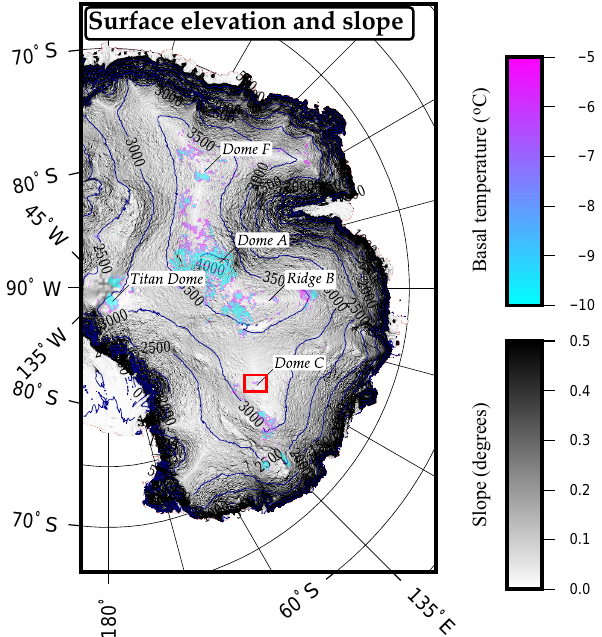
Figure 1. The East Antarctic ice sheet showing the Van Liefferinge and Pattyn (2013) frozen bed candidates and the location of Dome C; the region of interest is in the red box. Other potential old ice tar- gets include Dome F, Dome A, Ridge B, and Titan Dome. Surface elevation and slope are from Cryosat-2 (Helm et al., 2014). Projec- tion is Antarctic Polar Stereographic, (EPSG:3031) with latitude of true scale at − 71 ◦